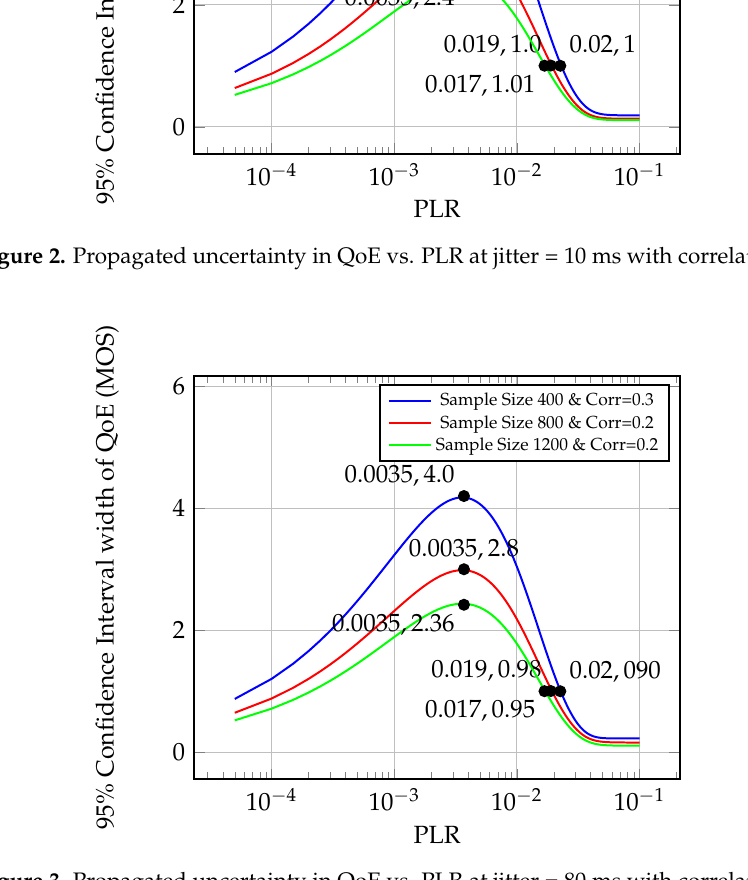
Figure 3. Propagated uncertainty in QoE vs. PLR at jitter = 80 ms with